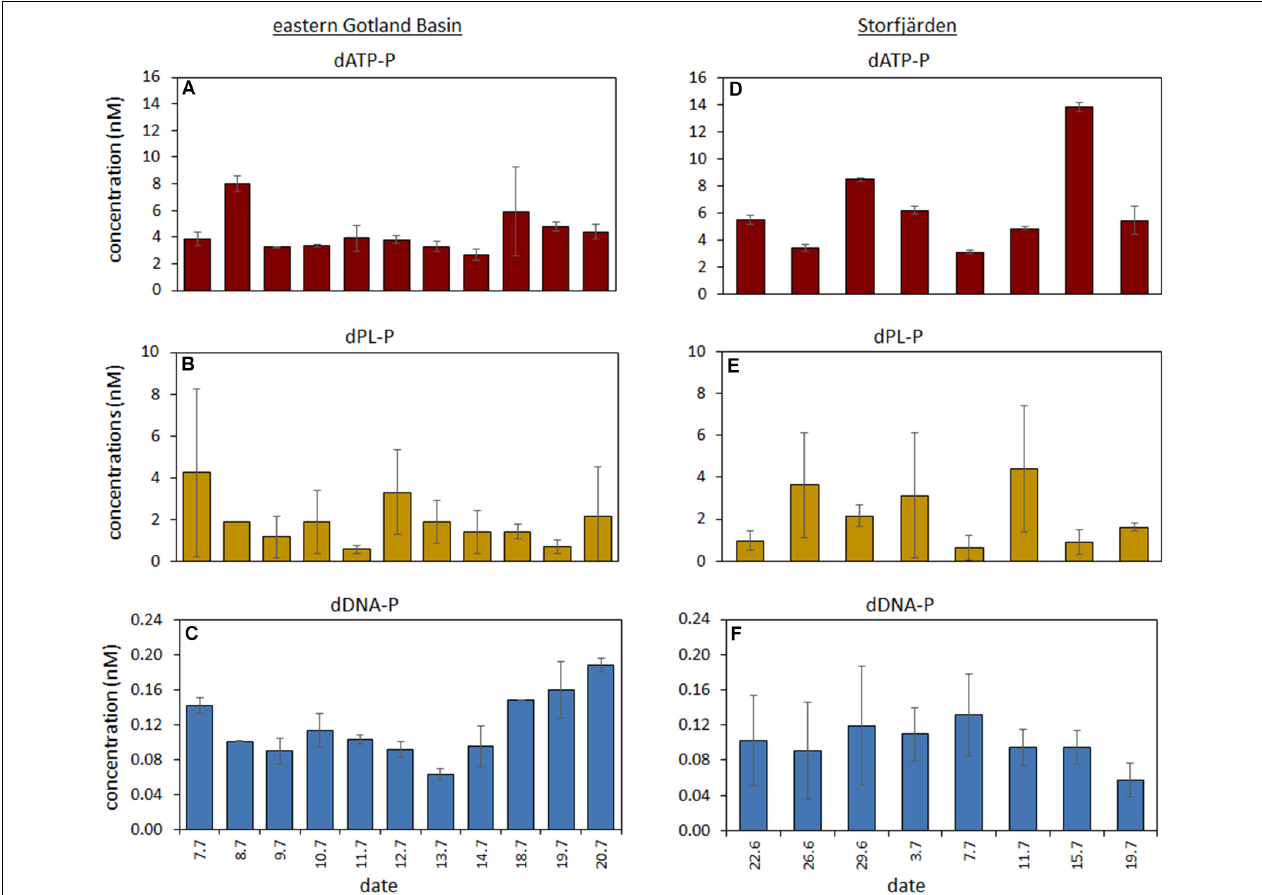
FIGURE 4 | Temporal variation of the concentrations of the DOP compounds during the time series in the eastern Gotland Basin (A–C) and in the Storfjärden (D–F) . Mean values of the 1 and 10 m are used for the eastern GB and for a depth integrated sample in the Storfjärden.